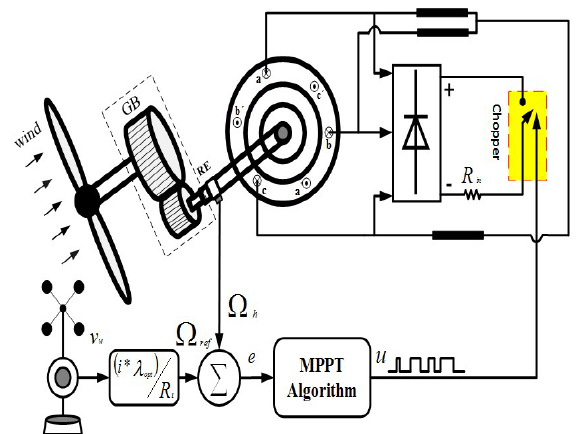
Figure 1. Schematic of the designed